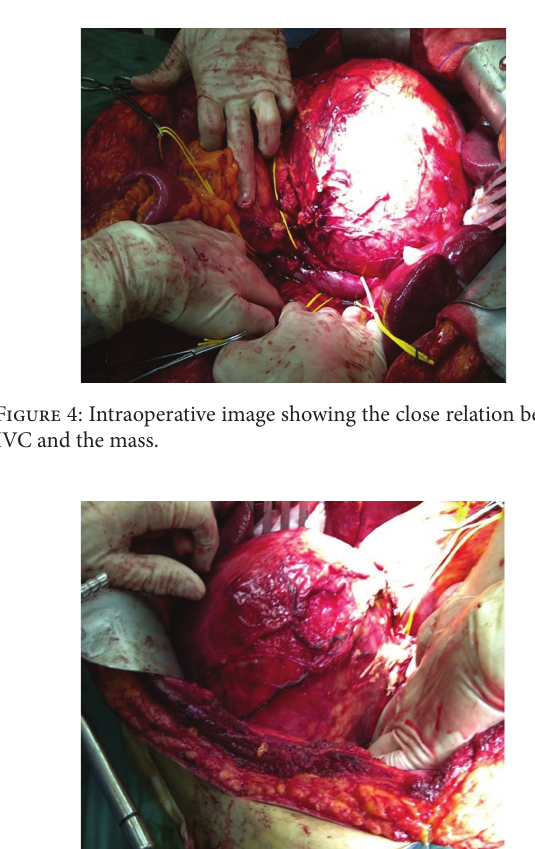
Figure 5: Intraoperative image during lesion